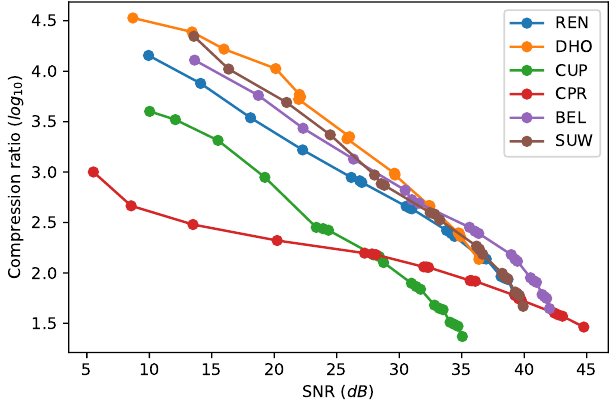
Figure 7. Distortion-ratio results for the optimal parameters from configurations F ( j ) , j = 0, . . .